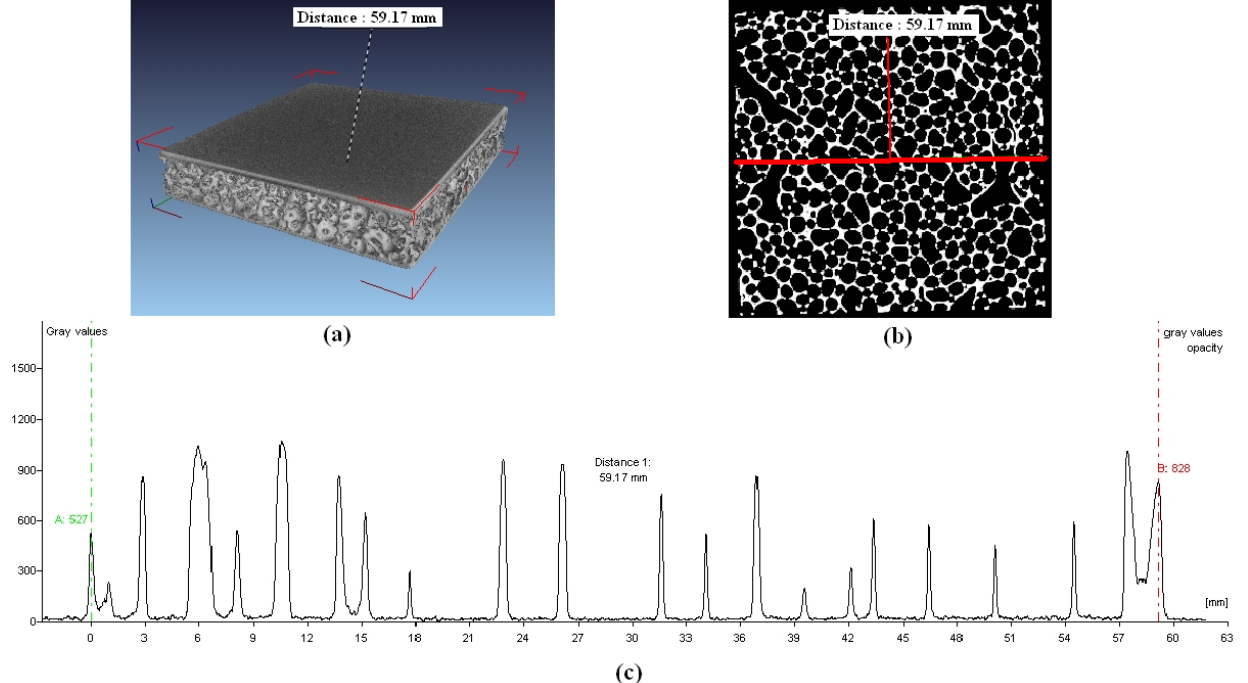
Figure 4. Computed Tomography ( CT ) analysis of an AFS Schunk panel.